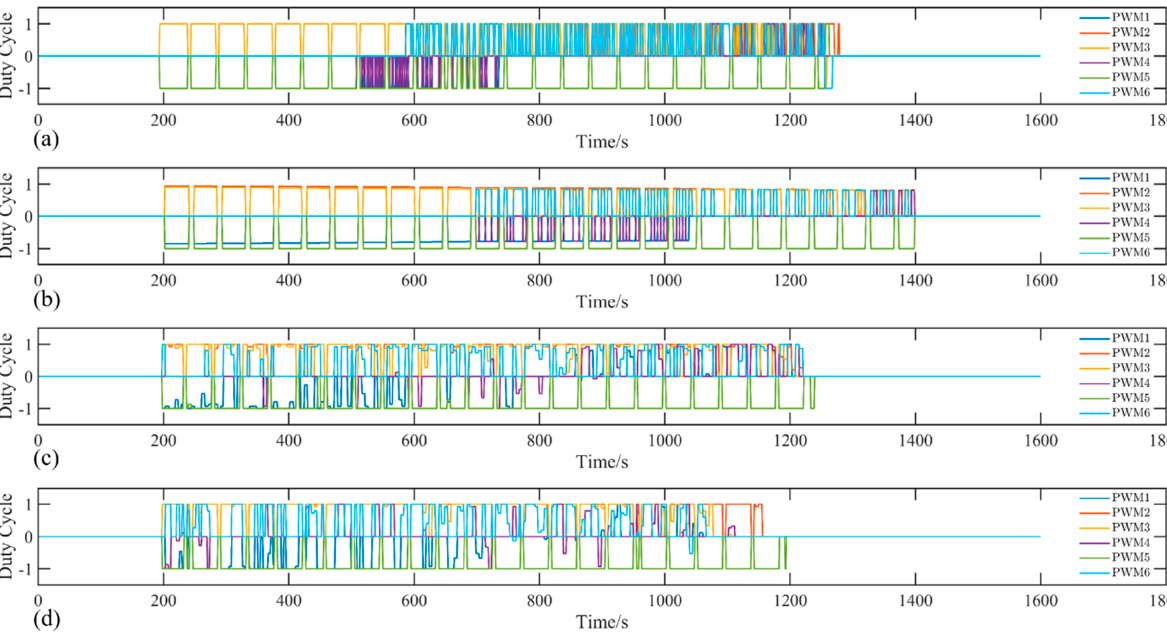
Figure 13. Duty Cycle of control signals: ( a ) FDC; ( b ) VDC; ( c ) GPC; ( d ) VSSGPC. Table 6. Equalization experiment result.